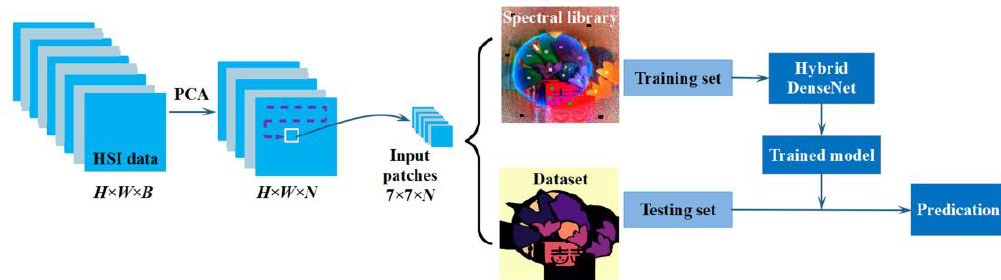
Figure 9. Hybrid DenseNet framework for active HSI classification.